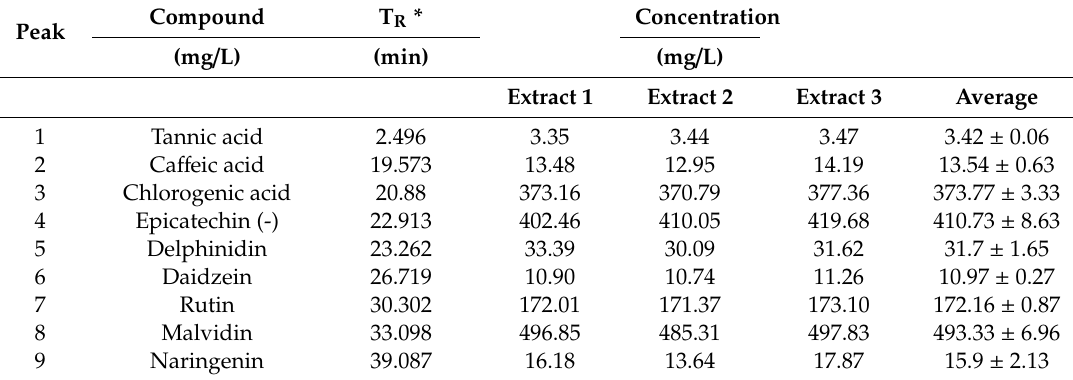
HPLC-DAD identification and quantification of some polyphenols from Anthriscus sylvestris extracts.